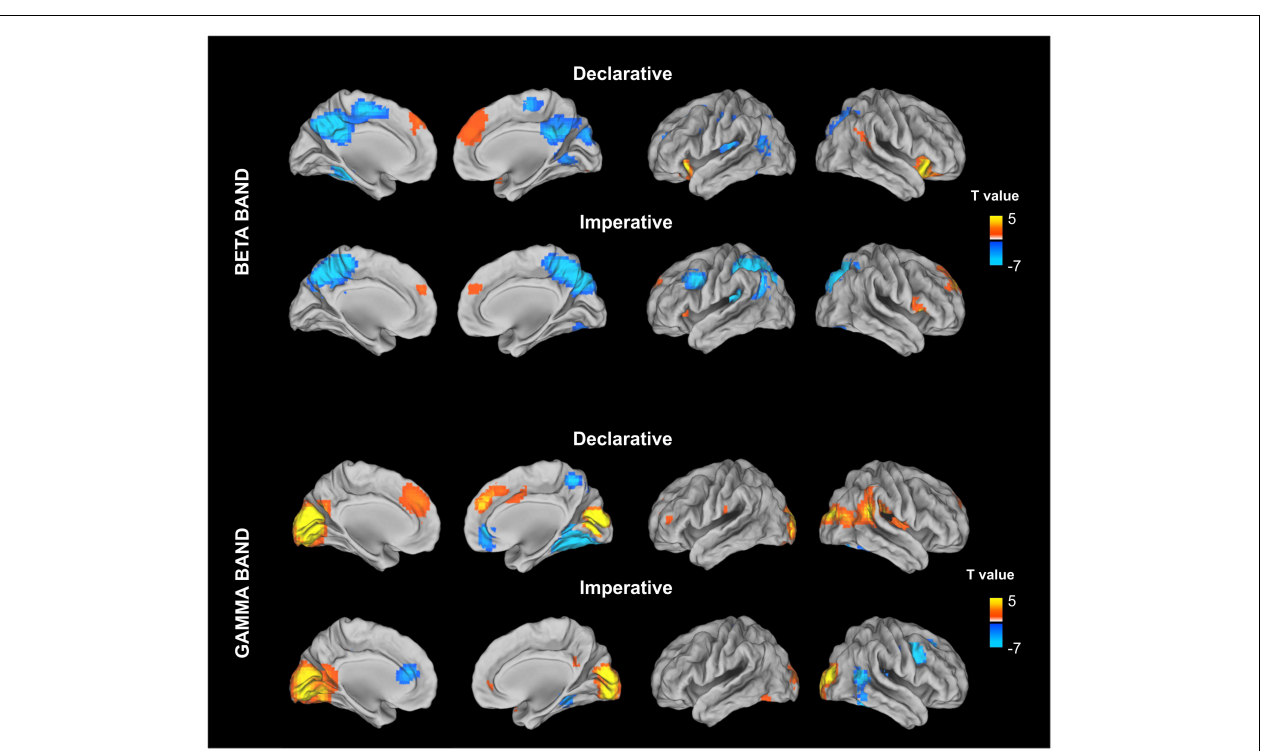
maps have been contrasting, at a group level, with the power in a baseline period (from − 500 to 0ms) prior to the stimulus image presentation.This contrast was implemented by using a paired t -test and the resulting maps were corrected for multiple comparisons by using the false discovery rate